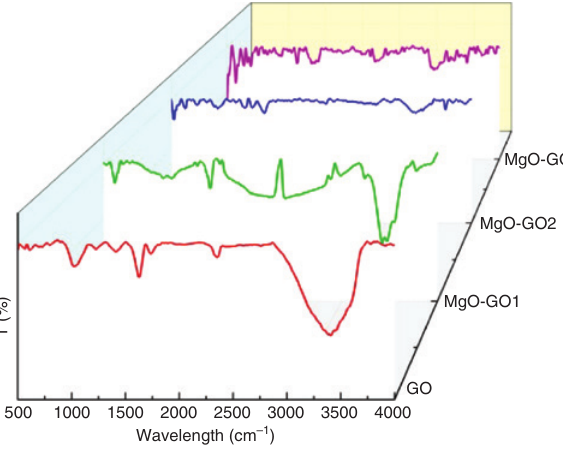
Figure 4: FTIR spectra of GO and MgO-GO